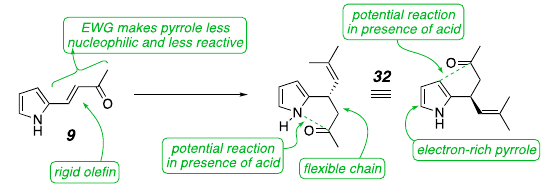
Figure 7. Pyrrole problems.